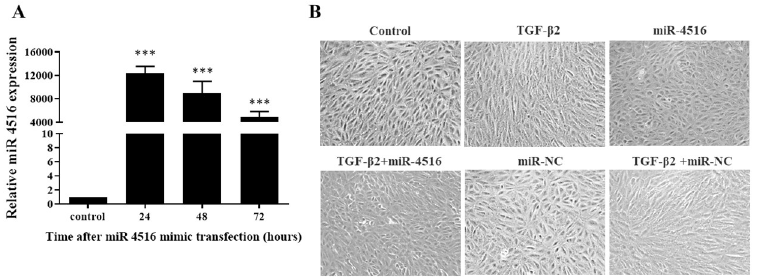
Fig 2. Transdifferentiationin RPE cells was inhibited by miR-4516 delivery. (A) The expression levels of miR-4516 in ARPE-19 cells transfected with negative control or a miR-4516 mimic, as determined through real-time quantitative polymerase chain reaction. ��� p < 0.001. (B) Morphologic alterations in ARPE-19 cells transfected with negative control or miR-4516 and incubated in the presence or absence of TGF- β 2 (10 ng/mL). The cells were examined by phase-contrast microscopy.